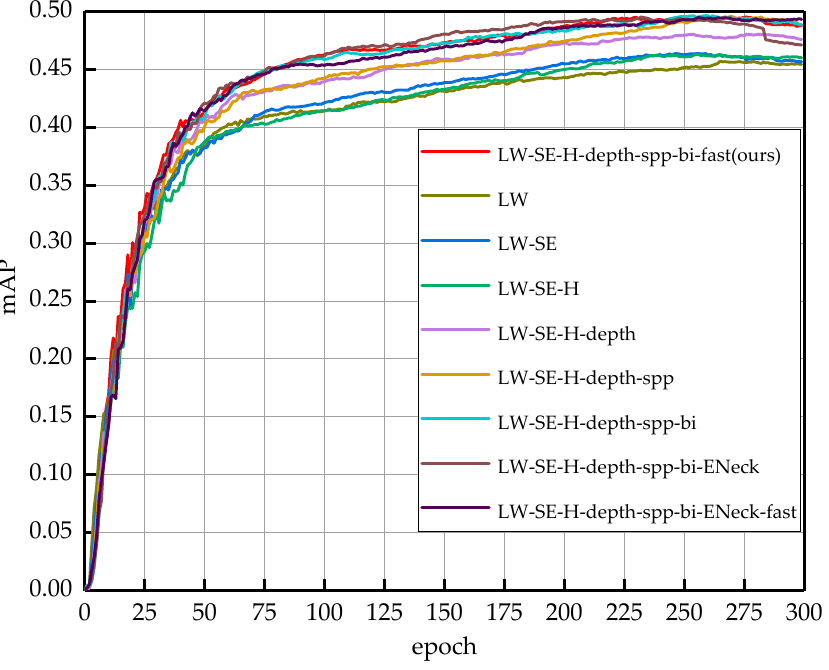
Figure 11. Performance comparison of the mean average precision using the training set of the RDD- 2020. These curves represent the different improvement methods, as well as the final model struc- ture.